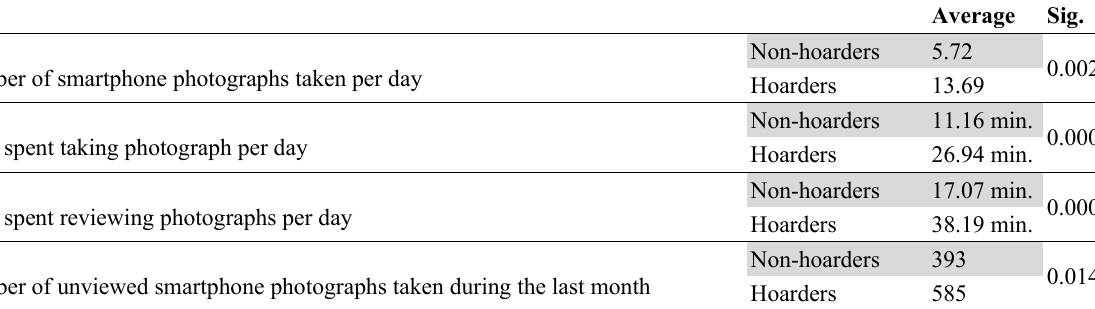
Relationship between Photographing Behaviors and the Scale